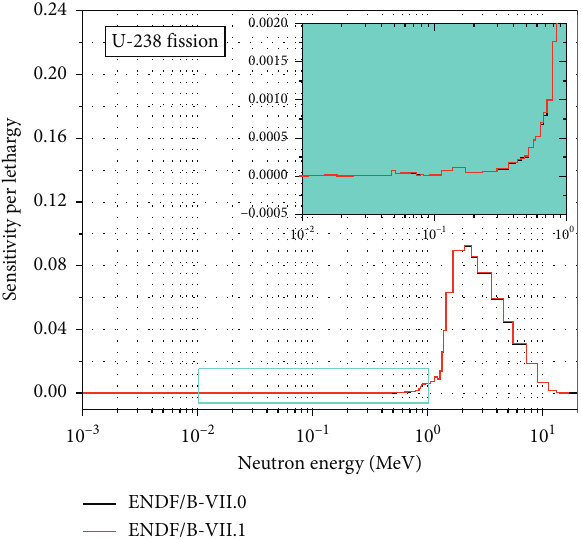
to 235 U fission eff